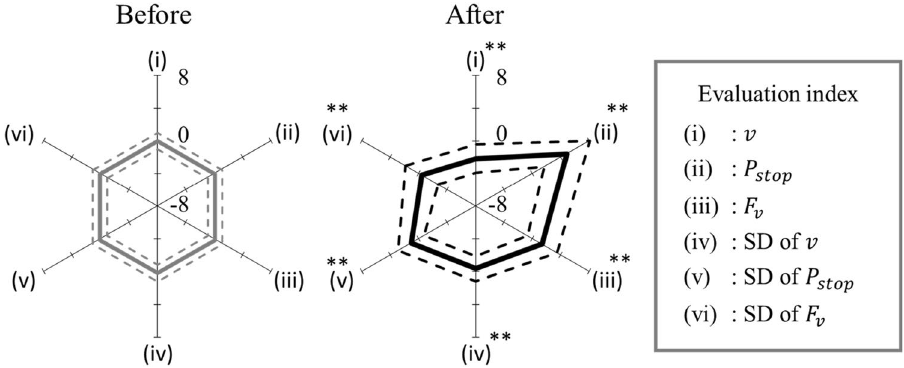
Figure 4. Radar chart for the evaluation indices before and after alarm pheromone exposure. The results indicate that the evaluation index values changed drastically after the fish were exposed to the alarm